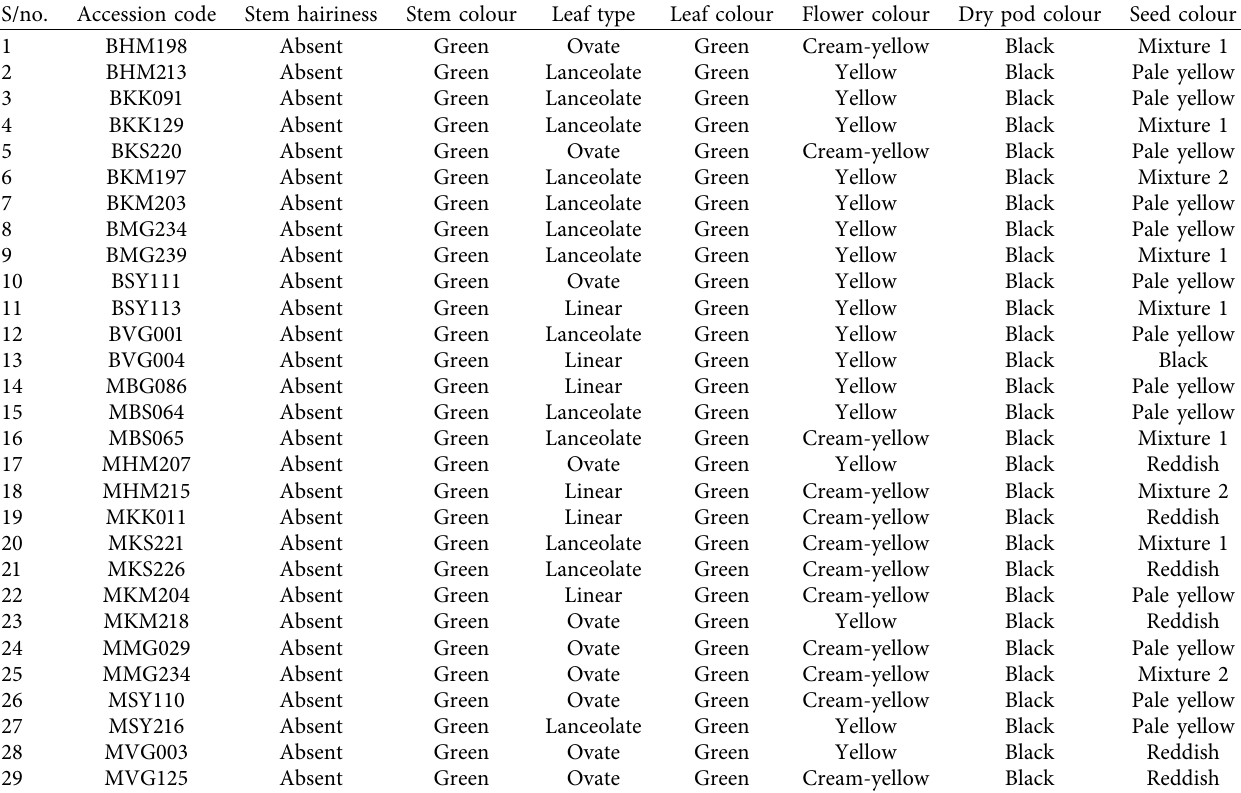
Table 2: Variation in qualitative characters among the 29 slender leaf accessions. S/no.